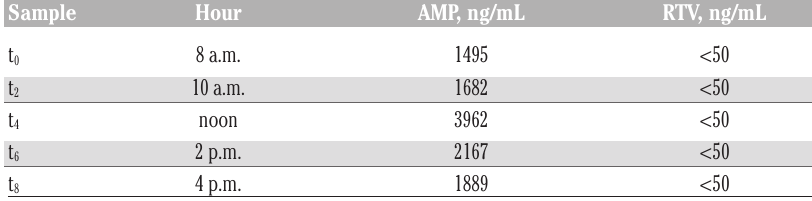
Table 2. Plasma concentrations of amprenavir and